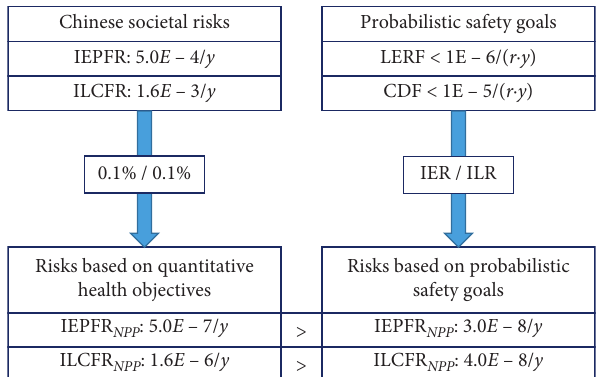
Figure 3: The rationality of existing probabilistic safety goals in